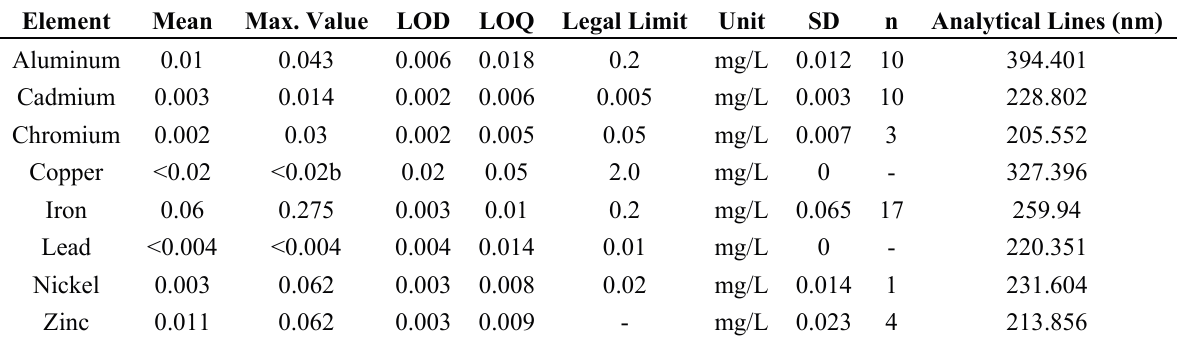
Table 6. Summary of the results in water sampled from supply reservoirs, including the mean concentration, maximum mean value, limit of detection (LOD), limit of quantitation (LOQ), legal limit, standard deviation (SD), n (number of samples above LOD) and the best analytical